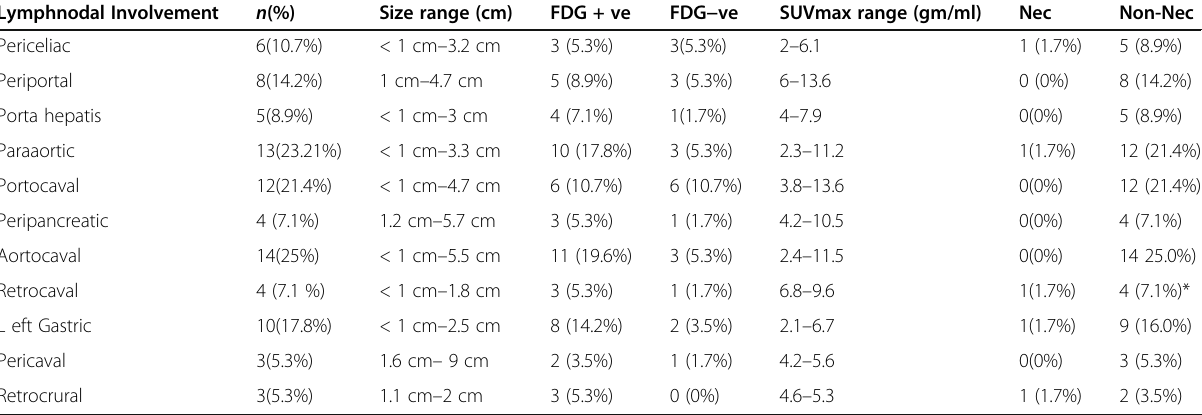
Table 5 Distribution of overall extrahepatic regional lymphnodal metastases of HCC on FDG PET CT in 56 patients Lymphnodal Involvement